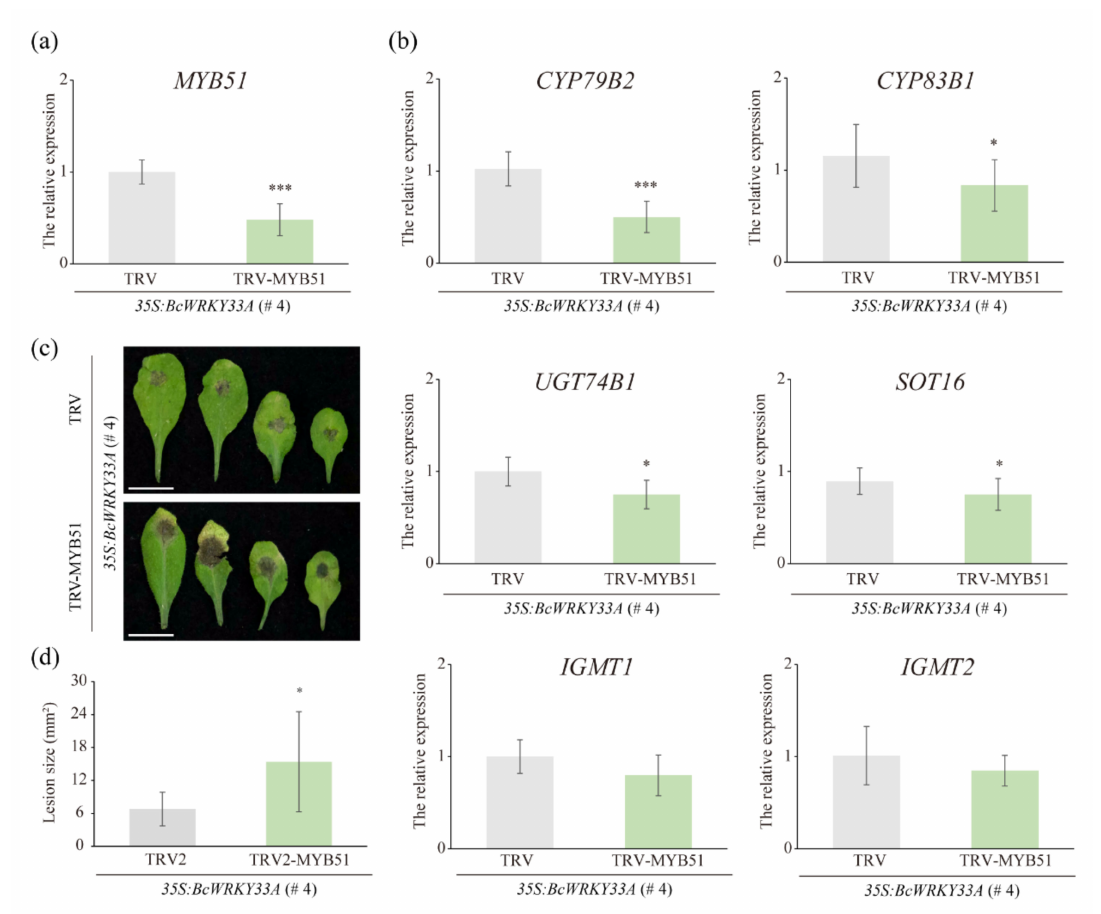
Figure 7. The silencing of MYB51 reduced the B. cinerea tolerance of 35S:BcWRKY33A trans- genic Arabidopsis . ( a , b ) The relative expression level of MYB51 ( a ) and IGSs’ biosynthetic genes ( b ) in TRV/ 35S:BcWRKY33A and TRV-MYB51/ 35S:BcWRKY33A lines. Data are means ± SD of four biological replicates. ( c , d ) The disease symptoms ( c ) and lesion size ( d ) of three-week-old TRV/ 35S:BcWRKY33A and TRV-MYB51/ 35S:BcWRKY33A lines in the background of overexpression of BcWRKY33A ( 35S:BcWRKY33A , # 4). Bars = 1 cm. After 2 dpi with a 5- µ L droplet of B. cinerea , the results of a representative experiment are shown in ( c ). The average lesion size was measured based on at least 16 leaves from at least 7 independent plants of each line. Error bars represent